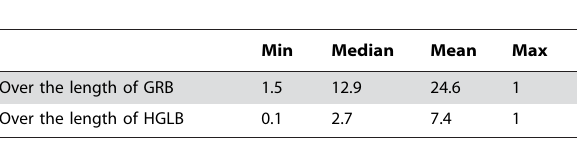
Table 2. Percentage of overlapping length of HGLBs and GRBs